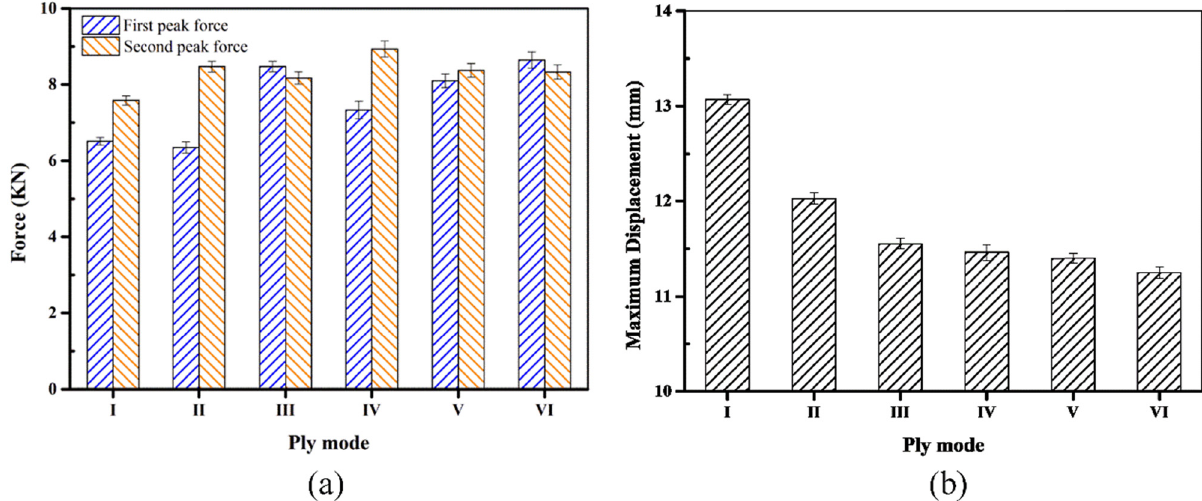
Figure 9: Values of the two peak contact forces ( a ) and maximum displacement ( b )